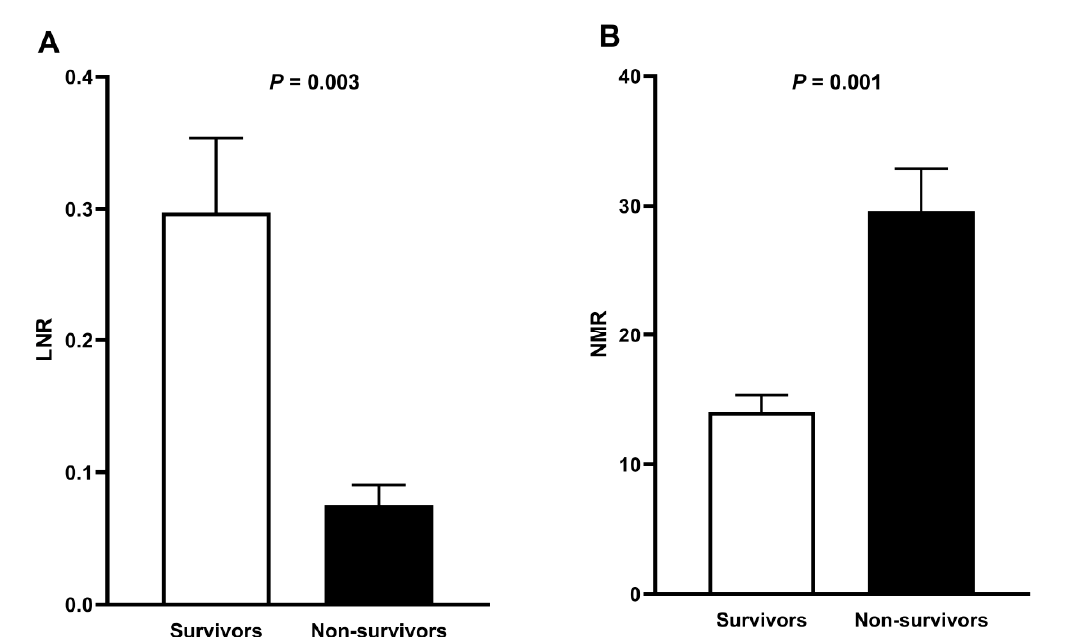
Figure 2. LNR and NMR at admission in hospitalized patients with severe Covid-19. ( A ) LNR showed a significant fourfold decrease in non-survivors as compared to survivors. LNR resulted of dividing the total lymphocyte count by the total neutrophil count. ( B ) NMR exhibited a significant twofold increase in non-survivors with respect to survivors. NMR resulted of dividing the total neutrophil count by the total monocyte count. Normality of data distribution was estimated by the Shapiro–Wilk test. The unpaired Student’s t -test was used to compare LNR and MNR between survivors and non-survivors, and data are presented as mean ± standard deviation. Differences were considered significant when p < 0.05. LNR, Lymphocyte-to-neutrophil ratio; NMR, neutrophil-to-monocyte ratio.